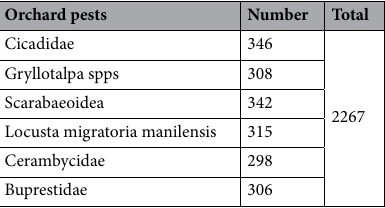
Table 2. Statistics information of PestImgData-2.